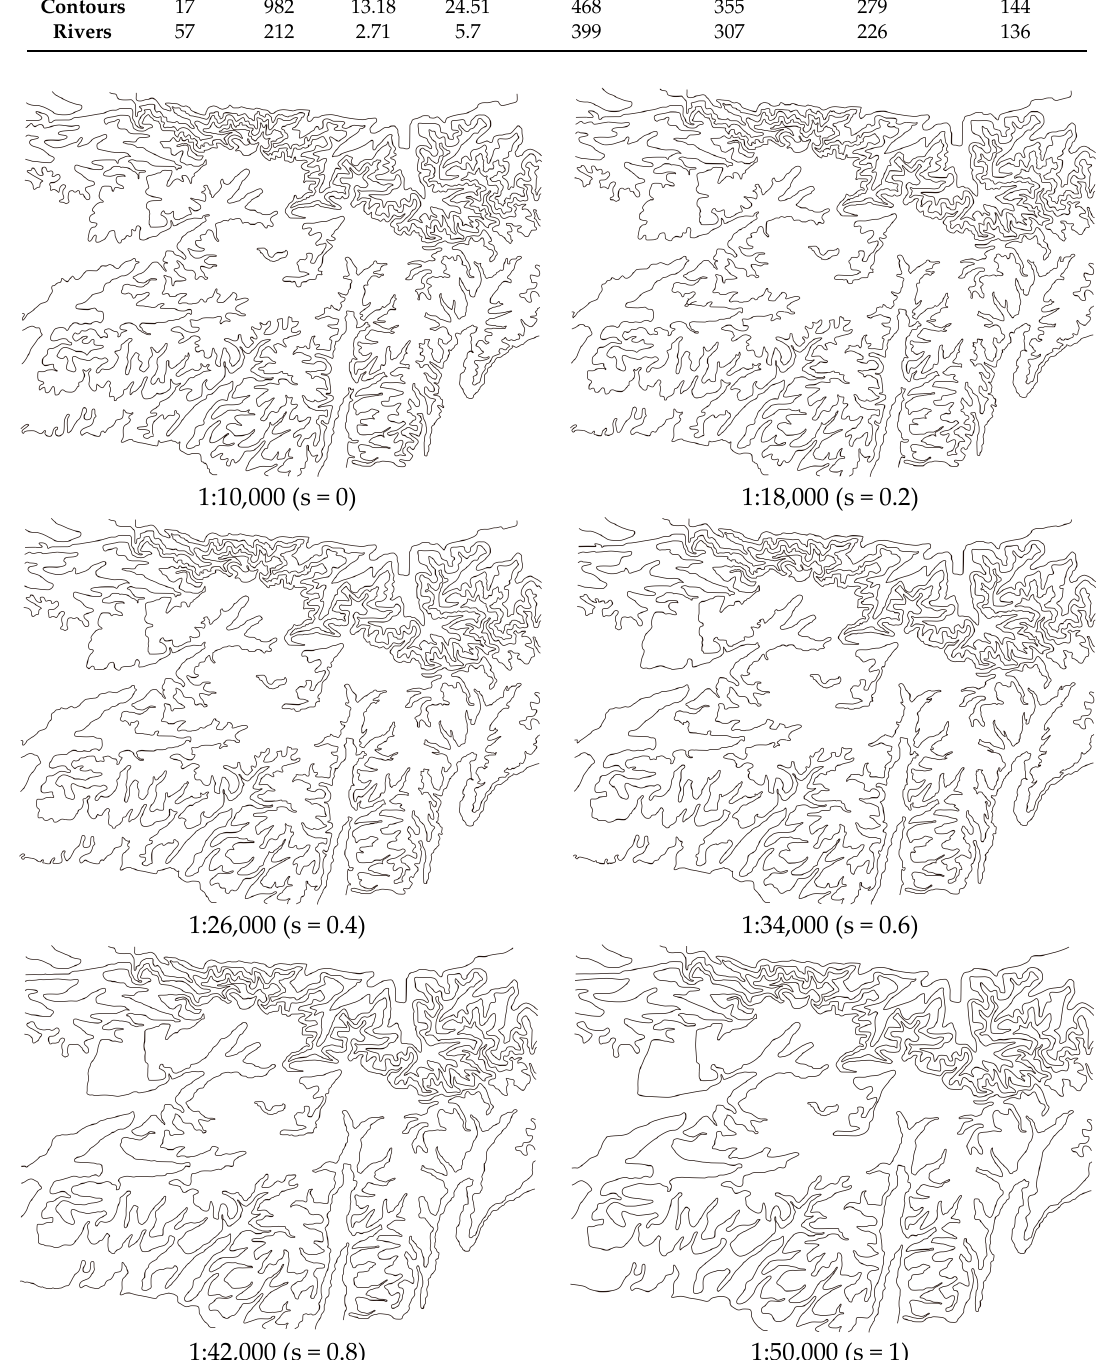
Figure 8. Contour morphing performed using the SABM method.